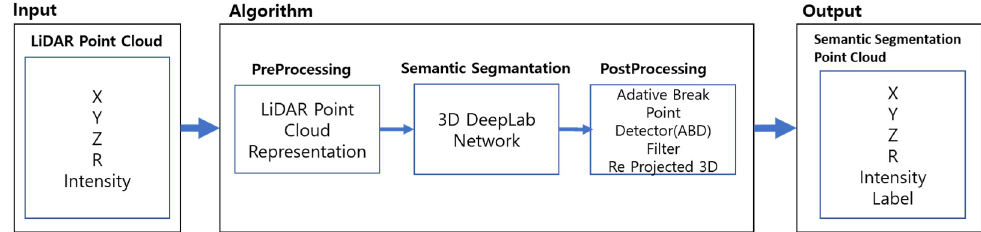
Figure 1. Point cloud spherical projection.